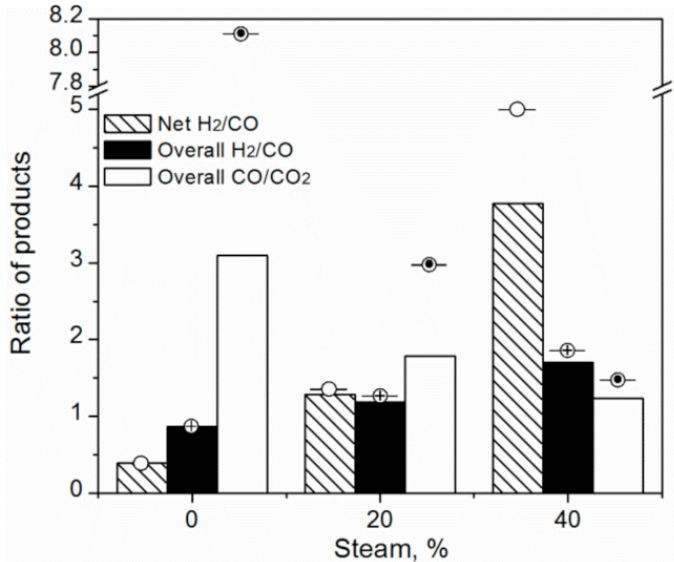
Figure 7. Comparison in the ratios of H 2 /CO and CO/CO 2 as a function of the steam concentration between the values from experiments (columns) and those from the thermodynamic equilibrium (symbols with bar) at 850 ◦ C.